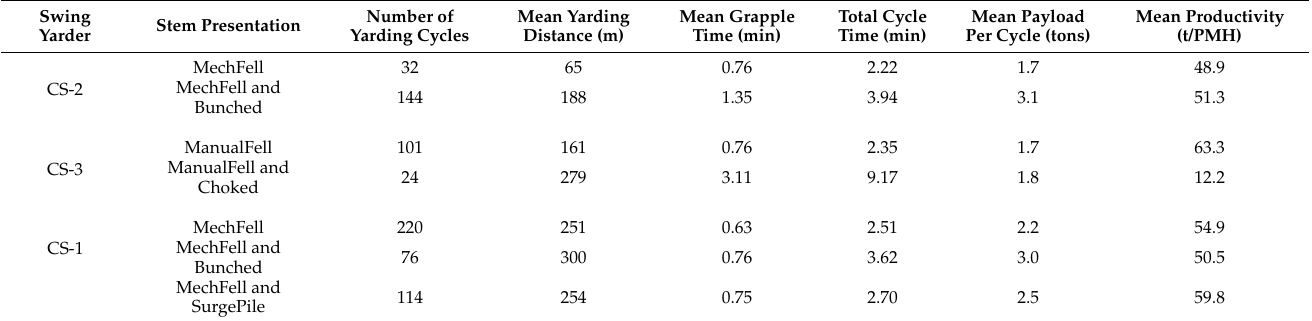
Table 4. Stem presentation and yarding cycle time and average productivity for the yarders studied.